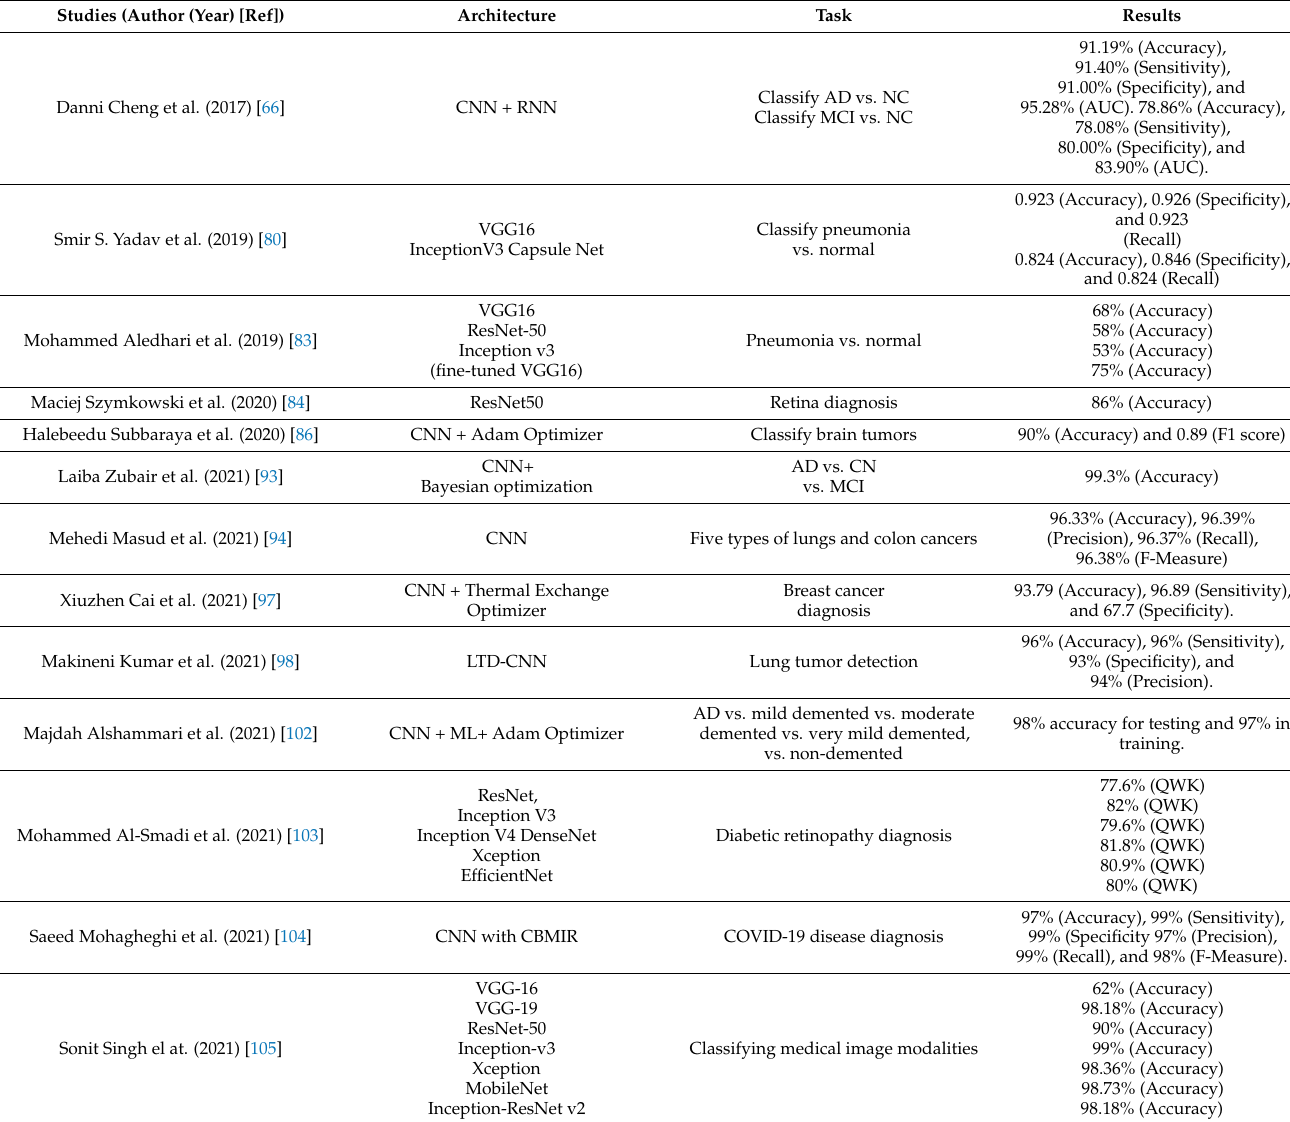
Table 5. Summary of articles that included deep learning in detecting